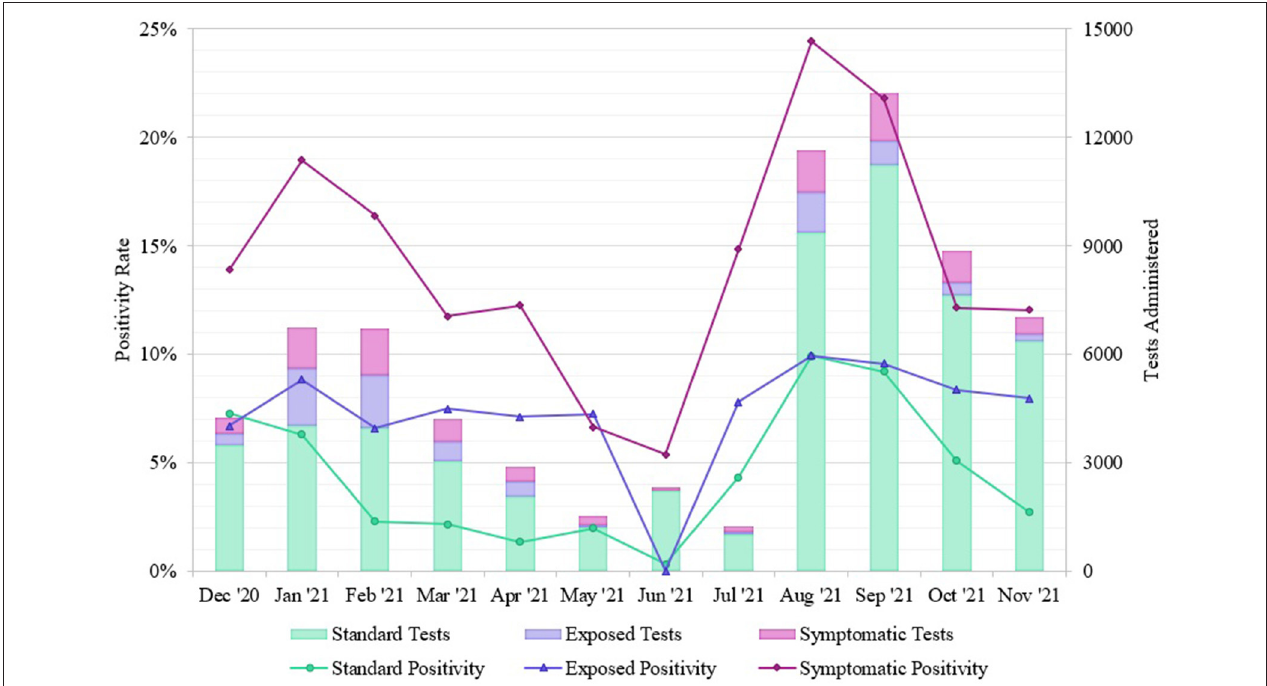
FIGURE 5 | Positivity rates of SARS-CoV-2 tests from different REDDI Lab community testing groups from December 1, 2020–November 30, 2021. Individuals self-reported exposures or symptoms during test initiation, so this can only serve as an approximate measurement. These data were obtained from the clinical reporting platform (Rymedi, version 1.0, Greenville SC,